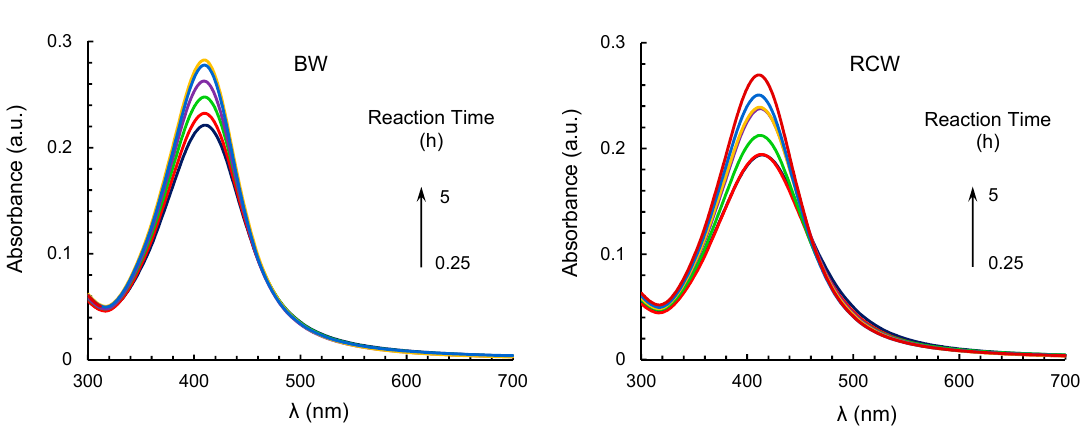
Figure 2. Spectrophotometric monitoring of the formation of silver nanoparticles (Ag-NPs) in reaction media containing silver nitrate and bilberry waste (BW) or red currant waste (RCW).